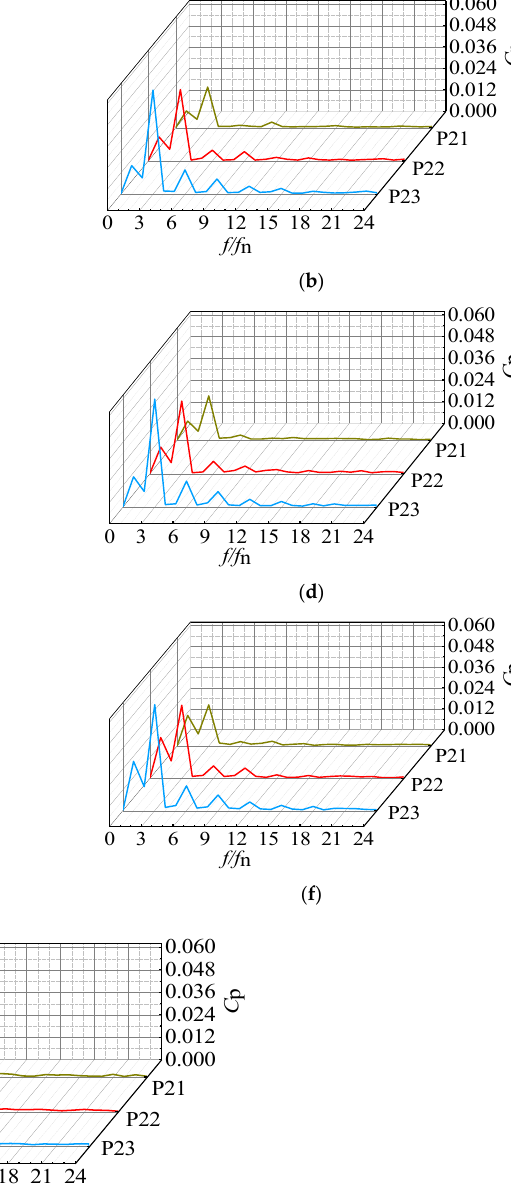
( c ) Figure 16. Trajectory distribution of the axial force under 1.0 Q des conditions: ( a ) no deviation; ( b ) deviation of a single blade; and ( c ) deviations of two blades. 0306090 120 150 180 210 240